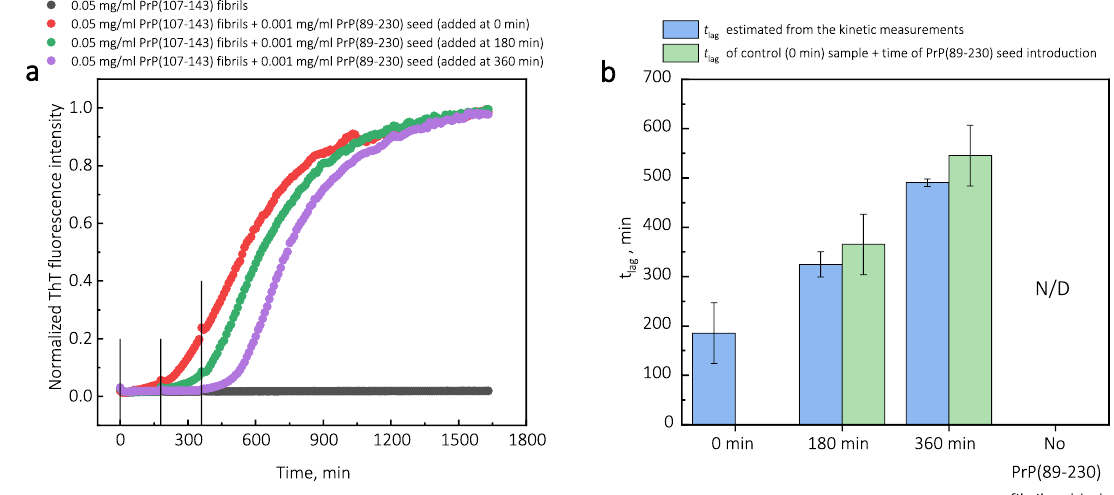
Figure A4. Average kinetic curves ( a ) and t lag values ( b ) of PrP(89-230) self-replication reaction performed with introduction of PrP(89-230) seed at different time-points of the reaction. Then, 10 µ L of 0.01 mg/mL PrP(107-143) fibrils were added to 100 µ L of PrP(89-230) solution (0.5 mg/mL of monomeric PrP(89-230) and 0.05 mg/mL PrP(107-143) fibrils) at a different time-points. The reaction kinetics were monitored by measuring ThT fluorescence intensity (ex. 440 nm; em. 480 nm) at 60 ◦ C through a bottom of non-biding 96-well plate (Corning No. 3881, New York, United States) using ClarioStar Plus (BMG Labtech, Ortenberg, Germany) microplate reader. The measurements were performed every ten minutes (the measurement frequency was reduced to avoid agitation-induced formation of PrP(89-230) aggregates, which in the presence of PrP(107-143) fibrils alone could lead to the false-positive results). The error bars are standard deviations estimated from 4